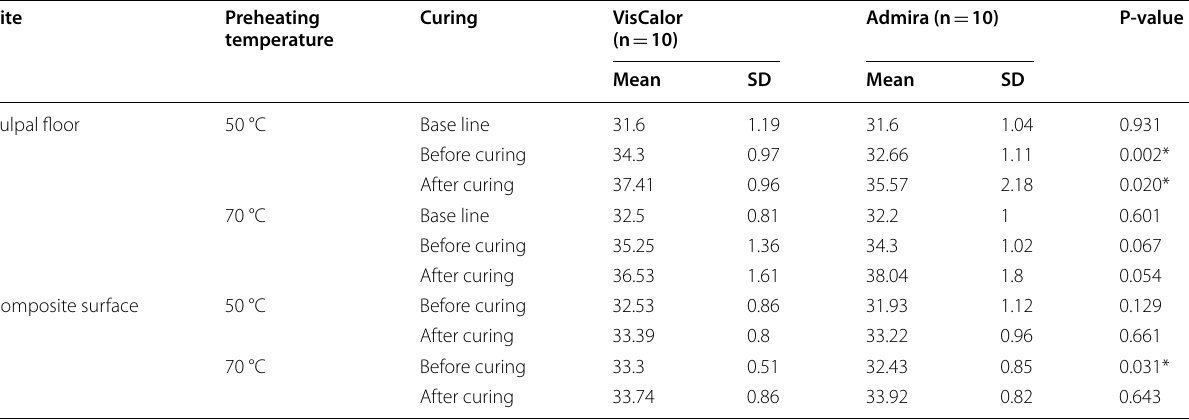
*Significant at P